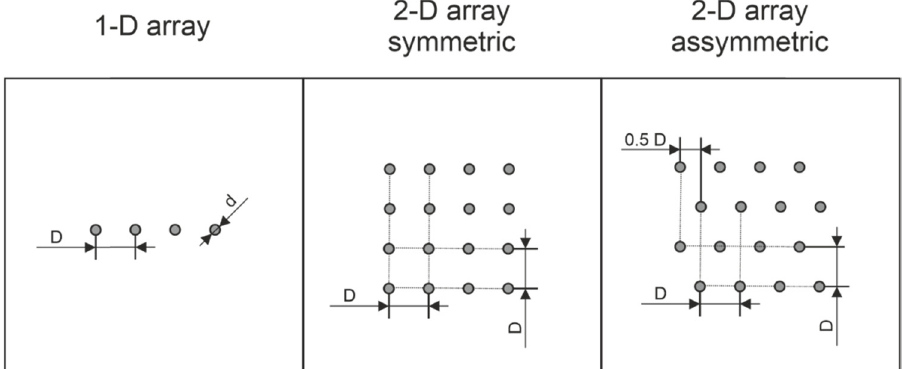
Figure 2: Basic types of pin